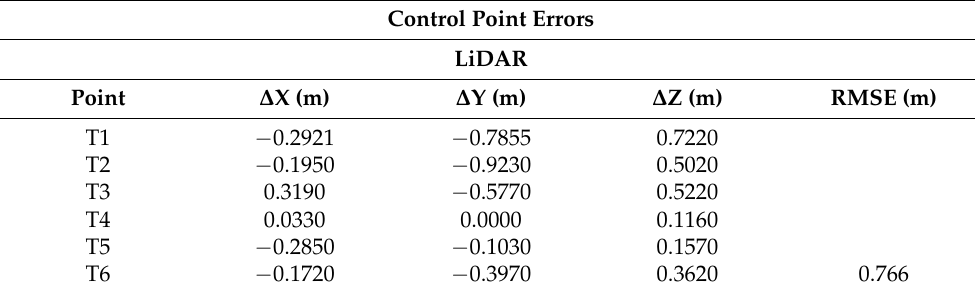
Table 10. Corrected control point coordinate errors.